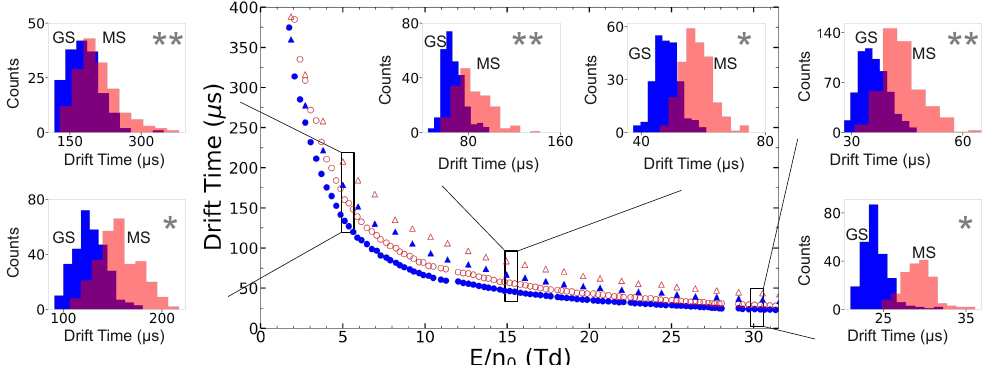
Figure 6. Absolute drift time comparison between ground and metastable states for both focused and unfocused beams. Unfocused beam: = ground state; (cid:13) = metastable state. Focused beam: = ground state; (cid:52) = metastable state. Insets: selected histograms for E/n 0 = 5, 15, and 30 Td to demonstrate resolution behavior. * = unfocused beam ; ** = focused beam; blue = ground state; red = metastable